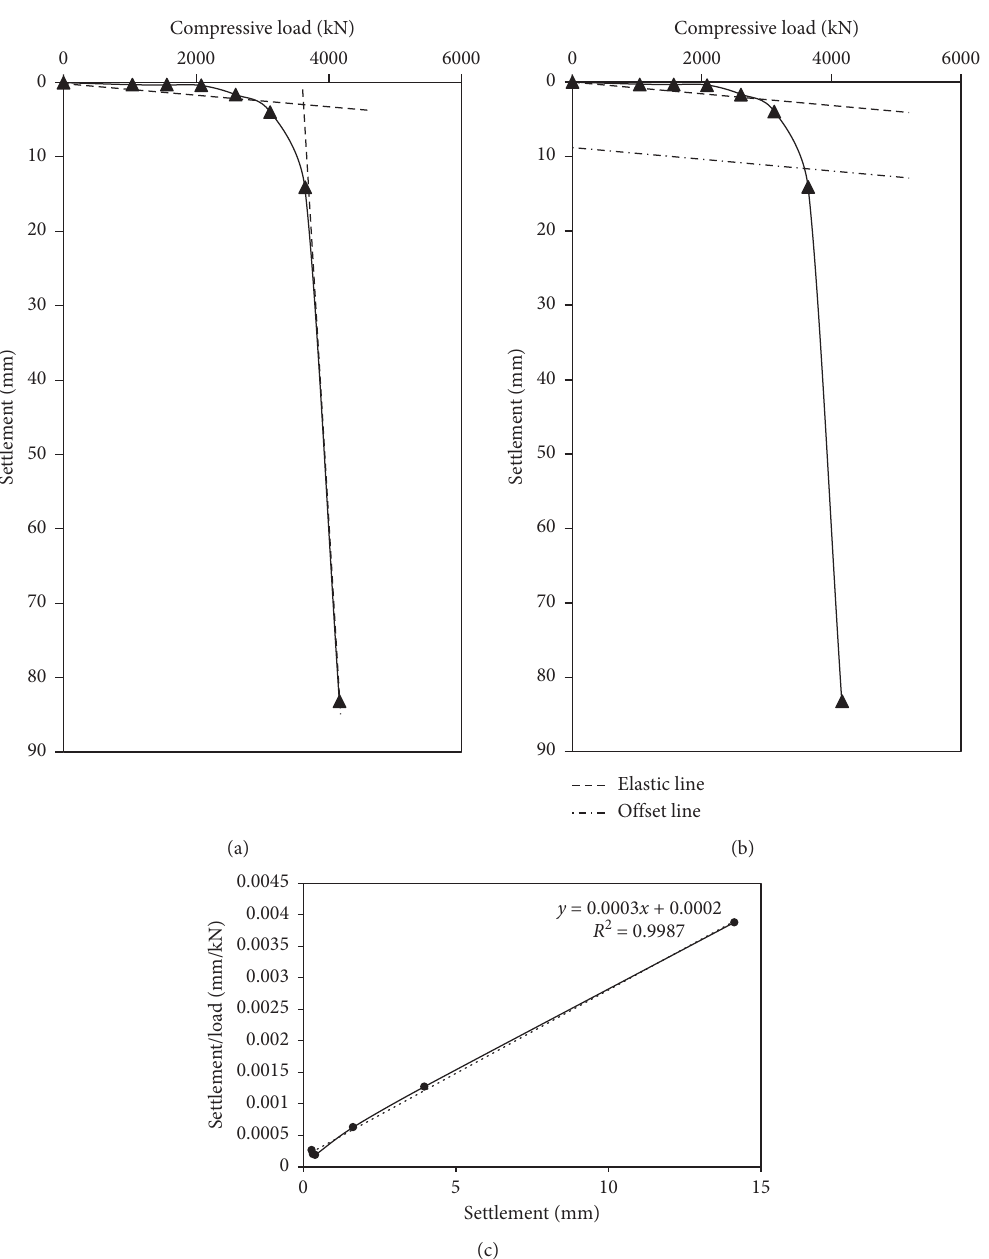
Figure 16: Interpretations of (a) the double tangent method; (b) Davisson’s offset method; and (c) Chin’s